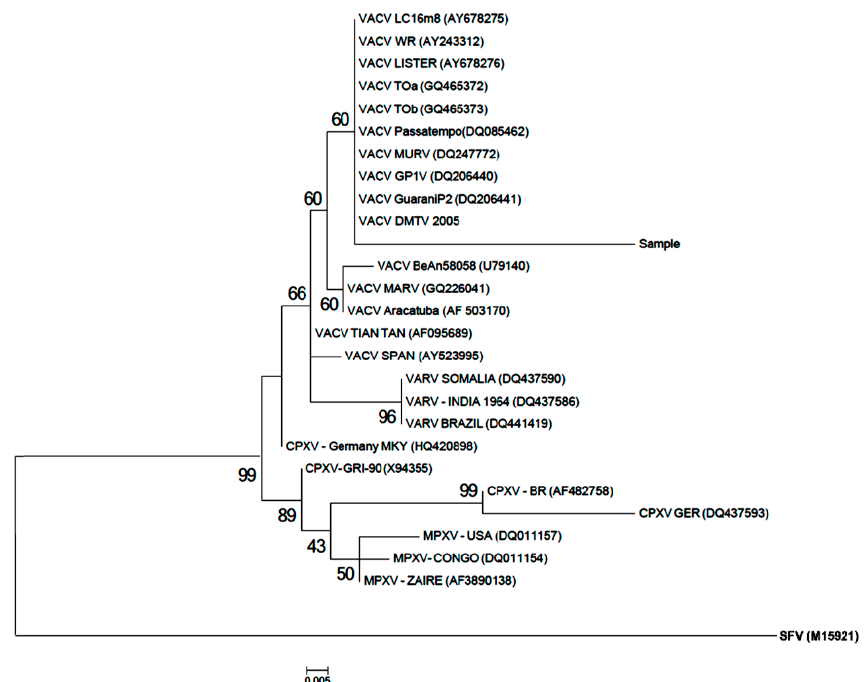
Figure 2. Phylogenetic tree based on the OPV nucleotide sequence of the vgf gene showing the rodent strain (sample) cluster. In bold, the out group shope fibroma virus (SFV).